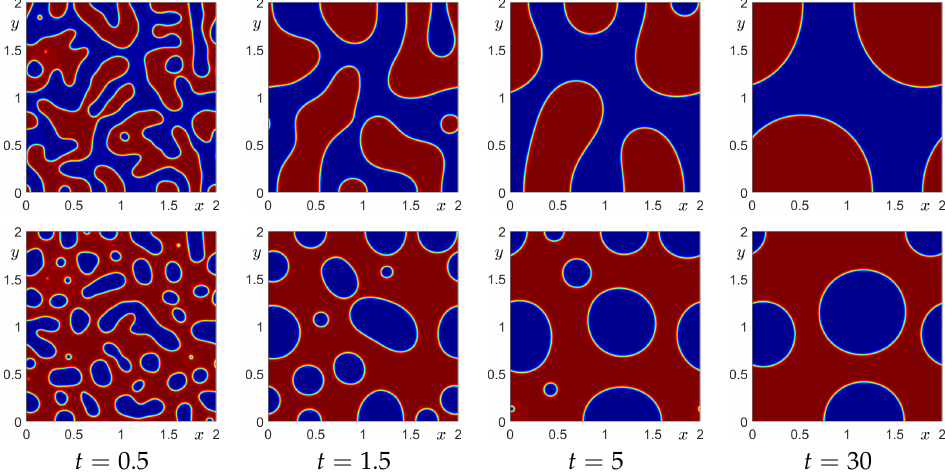
Figure 4. The top and bottom rows display the snapshots of φ with respect to ¯ φ = 0 and 0.3. The computational moments are illustrated under each figure.